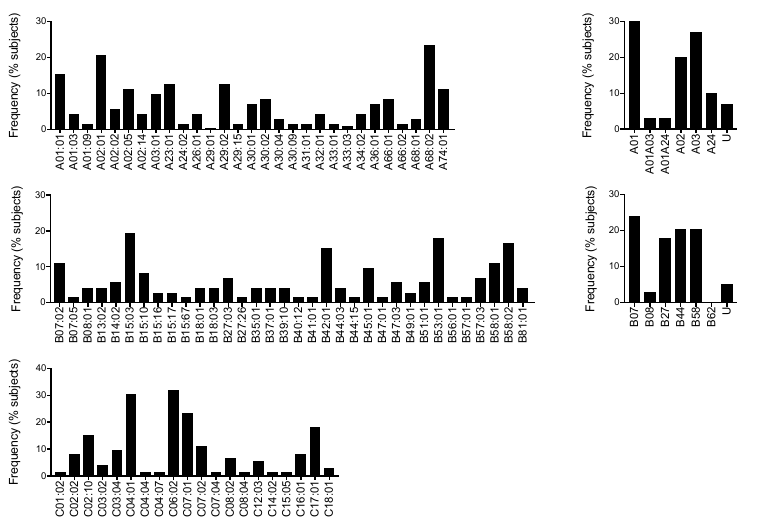
Figure 2. Human leukocyte antigen (HLA) class I alleles among Nairobi volunteers. HLA allele ( left ) and supertypes ( right ) frequencies are shown ( n = 72). U—unclassified supertype.